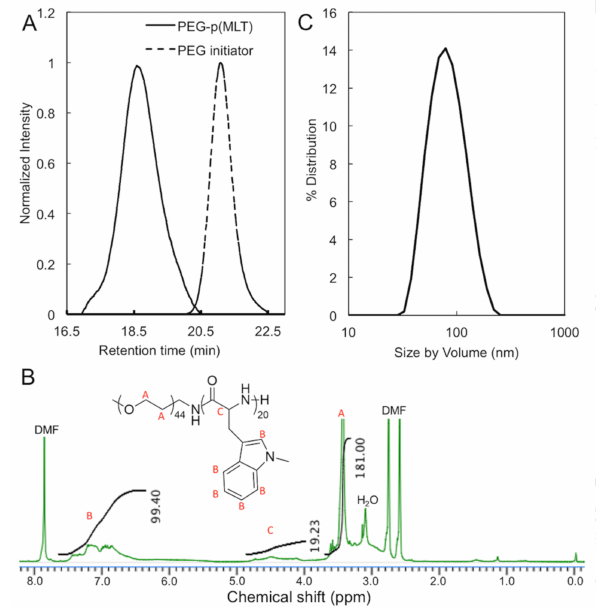
Figure 4. ( A ) GPC chromatogram of poly(ethylene glycol) (PEG) ( M w = 2000 Da) and PEG-P(MLT). ( B ) 1 H-NMR of PEG-P(MLT). ( C ) Dynamic light scattering (DLS) histogram obtained from self-assembly of PEG-P(MLT) in